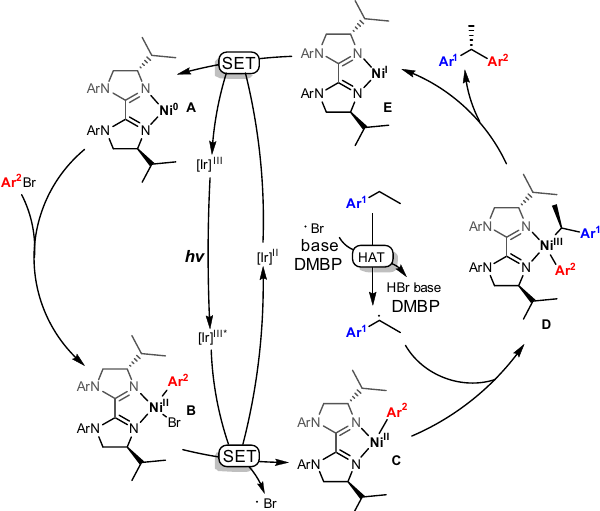
Fig. 4 Proposed mechanism. Visible light induced HAT by in-situ-generated bromine radical followed by the asymmetric cross-coupling to 1,1-diaryl